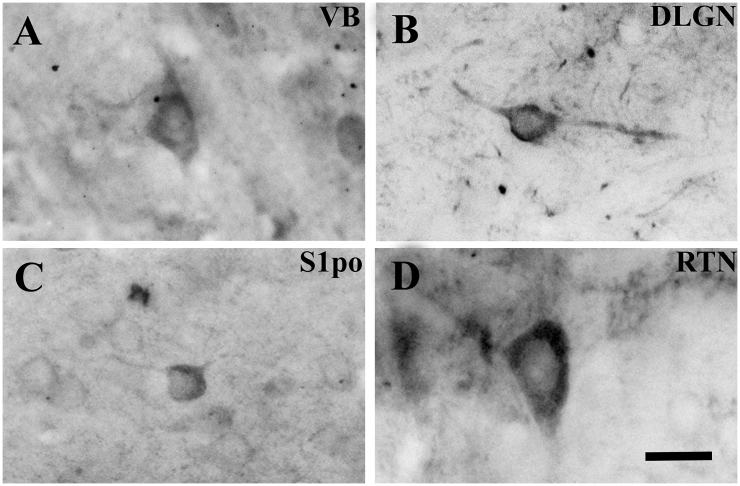
GABA-IR neurons in different thalamic and cortical regions.Brightfield photomicrographs of coronal sections showing representative examples of GABA-IR neurons in ventrobasal thalamus (VB) (A), dorsal lateral geniculate nucleus (dLGN) (B), peri-oral region of the primary somatosensory cortex (S1po) (C), and nucleus reticularis thalami (NRT) (D). Note that in VB, dLGN and S1po GABA-IR neurons show a multipolar (A,C) or fusiform (B) shape that corresponds to classical GABAergic interneurons. The GABA-IR neuron in the NRT (D) has typical multipolar appearance of neurons in this thalamic nucleus. Scale bar = 15 μm in A also applies to B-D.